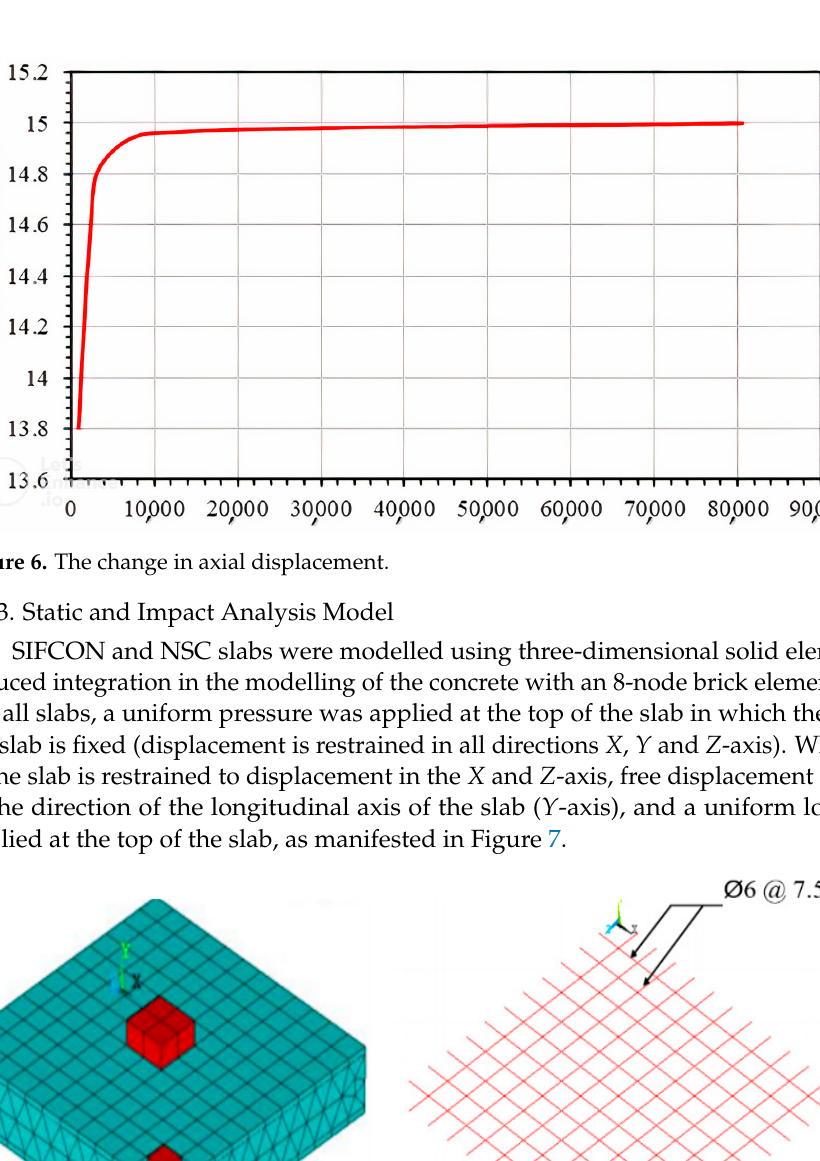
Figure 6. The change in axial displacement.